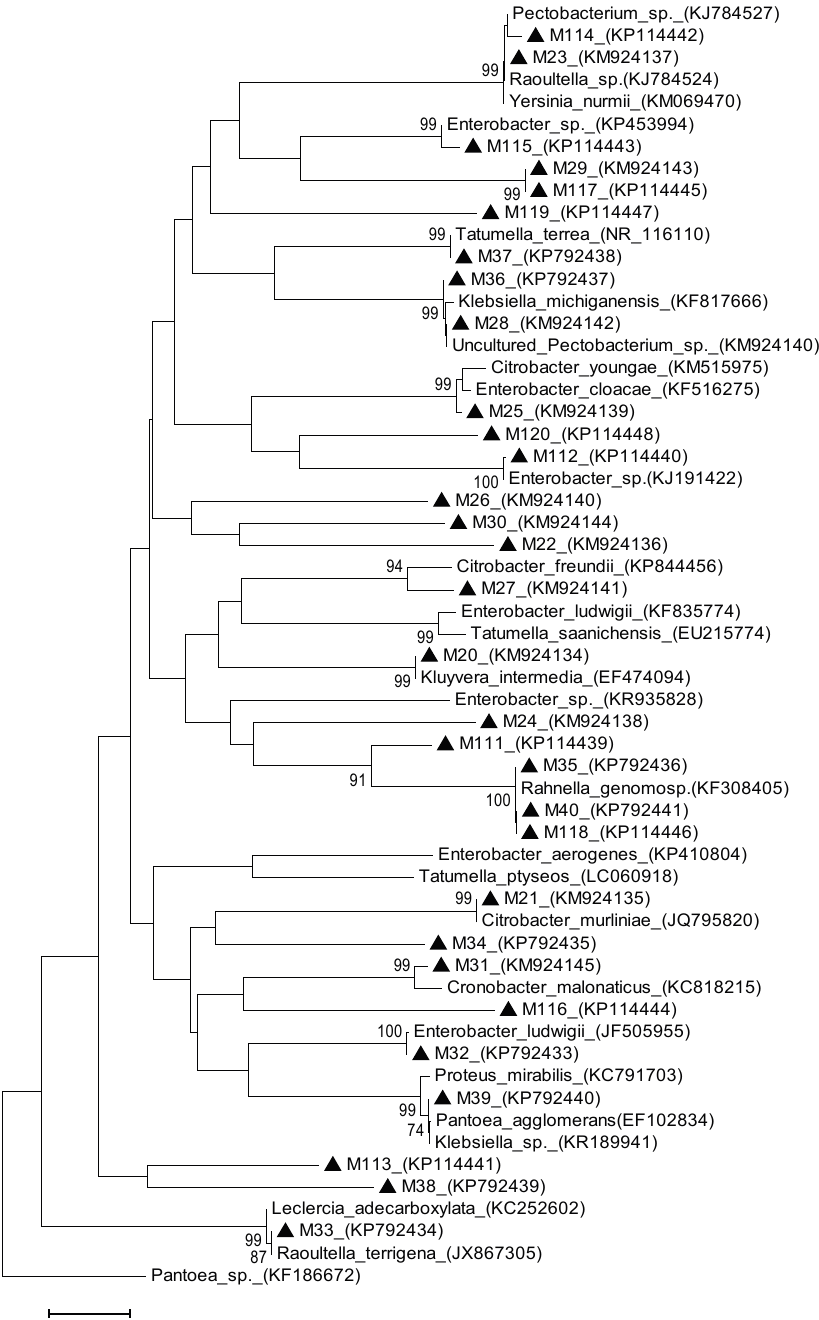
Figure 4. Neighbor Joining method of phylogenetic tree based on partial 16S rDNA gene sequence, showing the phylogenetic relationships between macergens and the most closely related strains from the GenBank. Numbers at the nodes indicate the levels of bootstrap support based on 1000 resampled data sets. Only values greater than 50% are shown. The scale bar indicates 0.5 base substitution per site. Pantoea species were set as the out-group. Sequences obtained in this study are denoted with a triangle